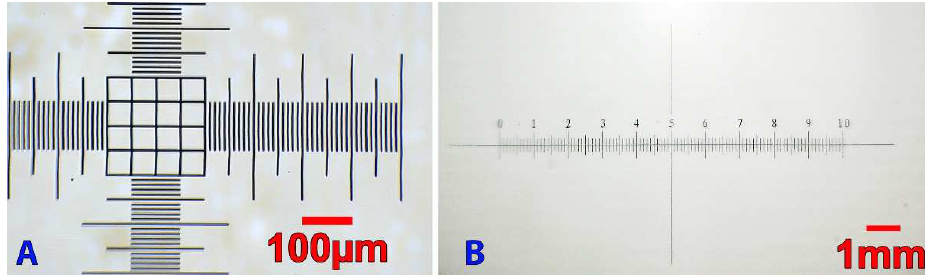
( A ) was calibrated with a 10 µ m/division slide and the 16 mm lens ( B ) has been calibrated with a 100 µ m/division reference